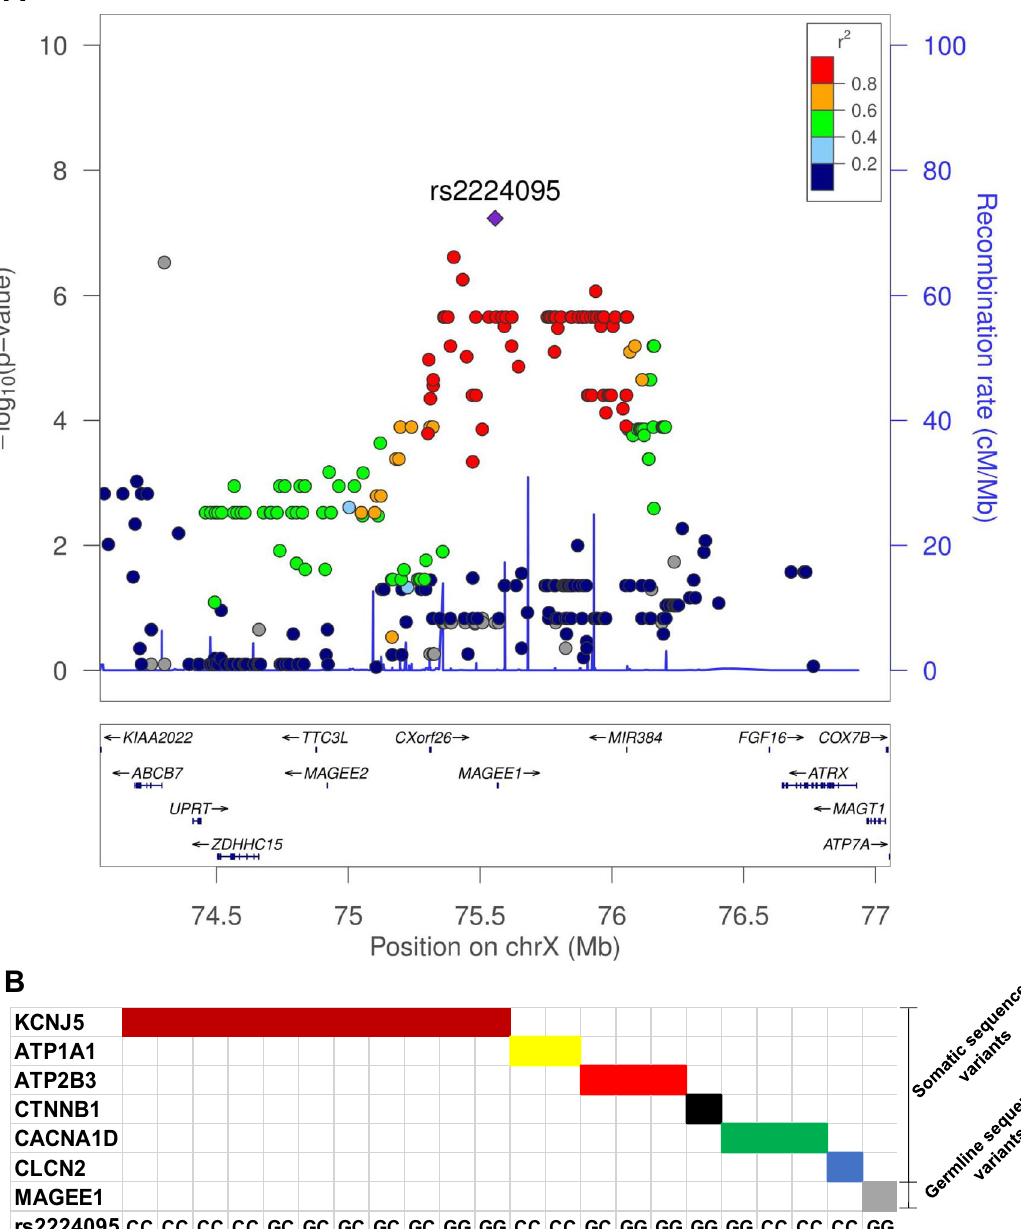
Figure 2. ( A ) Regional association plot. The plot shows the association results of SNPs of the GWAS samples and the recombination rates. The –log10 P values (y axis) of the SNPs are shown according to their X-chromosome positions (X axis). The lead SNP (rs2224095) is shown as a diamond. The intensity of each symbol reflects the extent of LD with rs2224095. Genetic recombination rates were estimated using HapMap samples from Utah residents of Western and Northern European ancestry (CEU) and are shown as a blue line. Physical positions are based on hg18. (B) A summary of mutations and genotype of sentinel SNP (rs2224095) identified in 24/35 of our cohort of APAs. The remaining APAs had no mutations in the known susceptibility